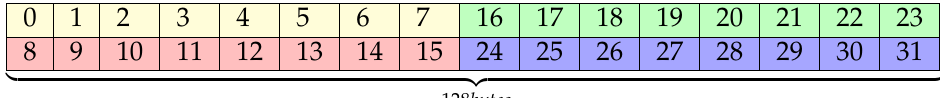
Figure 14. Layout STG.64 from registers to global memory (fully